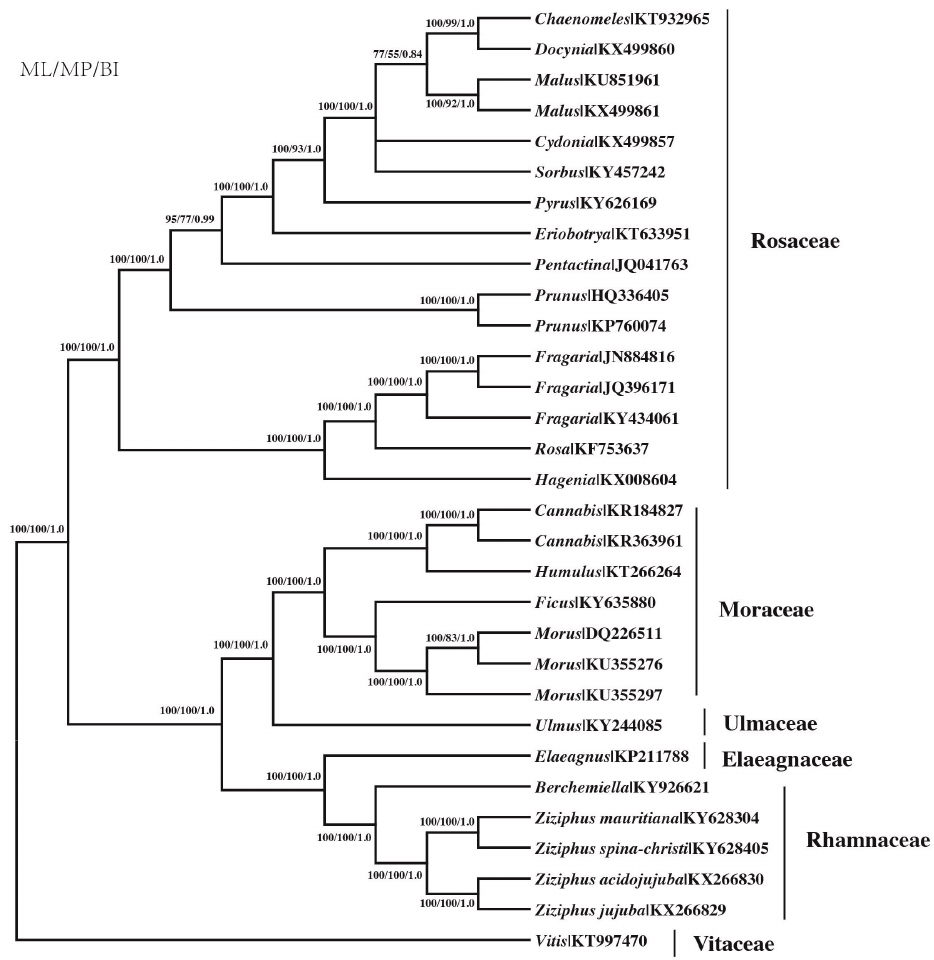
Figure 5. Phylogenetic tree reconstruction of the 31 species inferred from maximum likelihood (ML), maximum parsimony (MP) and Bayesian inference (BI), based on 78 protein-coding genes using a non-partitioning scheme. Numbers above the lines represent: ML/MP bootstrap values/BI posterior probability.